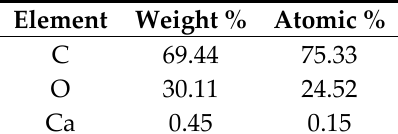
Figure 4. Scanning electron microscopy images of ( a ) untreated and ( b – e ) Ca(OH) 2 -treated G. angustifolia samples: ( b ) chips, ( c ) barkless, and ( d , e ) crushed (the circles in ( e ) indicates the calcium compounds on the surface).